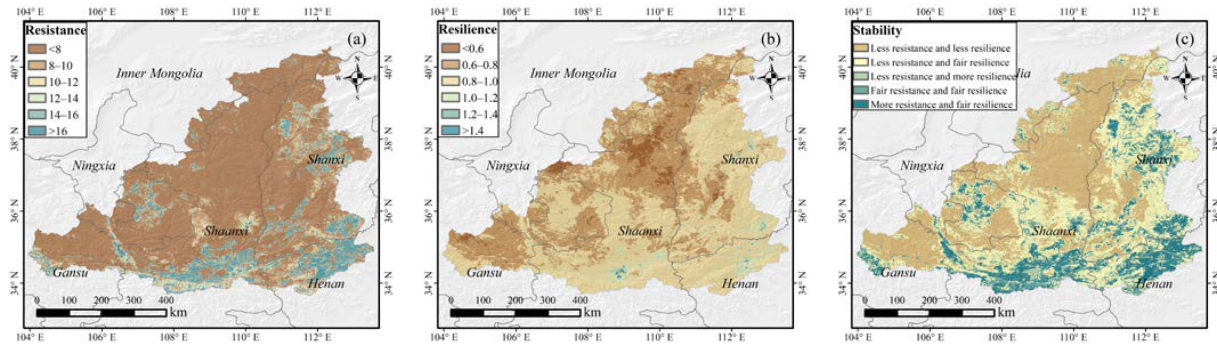
Figure 3. The spatial patterns of vegetation ( a ) resistance, ( b ) resilience, and ( c ) stability in the MRYRB